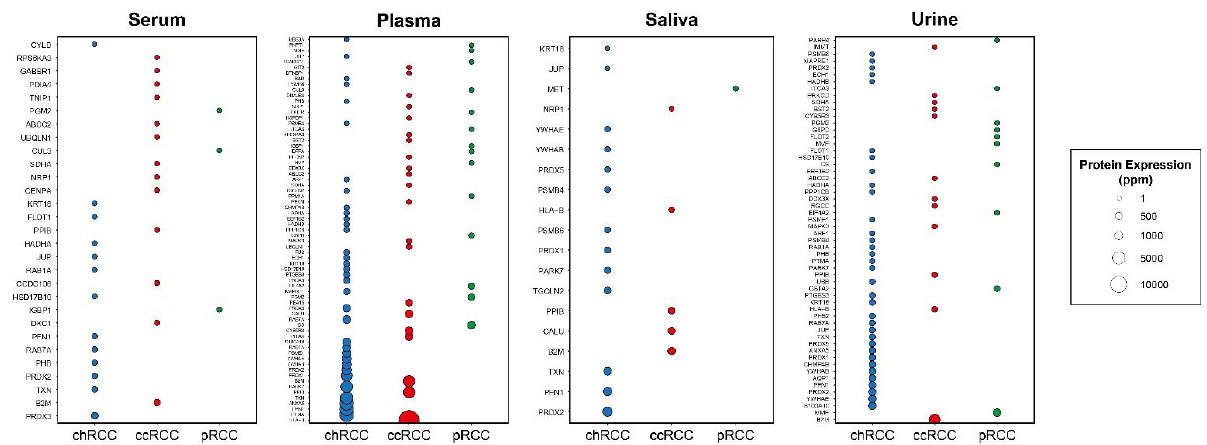
Figure 2. Bubble plots indicating protein expression levels of DIPs specific to three subtypes in different body fluids including serum, plasma, saliva, and urine. The x-axis indicates subtypes while the y-axis indicates protein symbols.